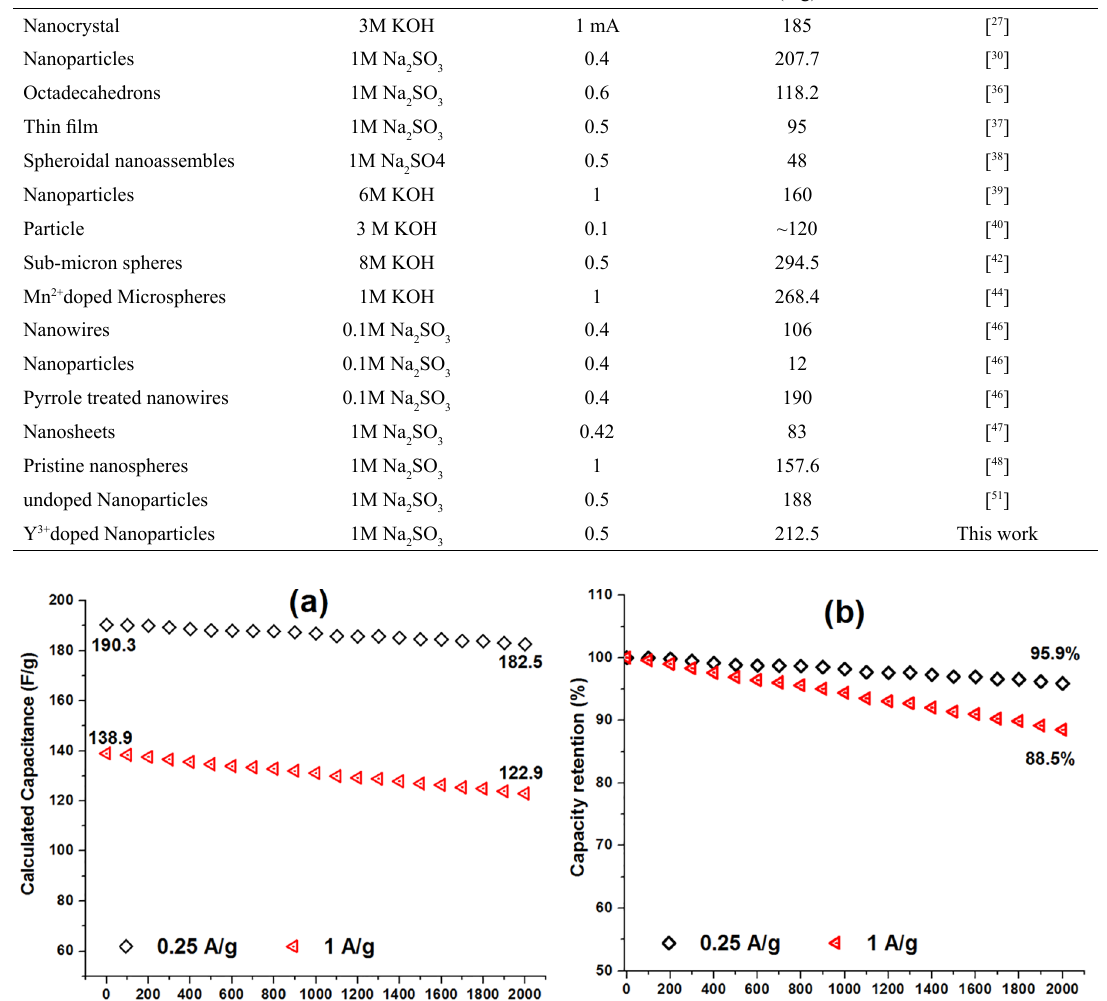
Table 2. Electrochemical capacitance values reported for Fe3O4 based working electrodes Structure type